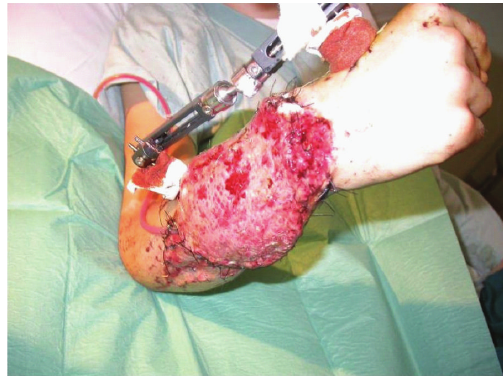
Figure 7: X-ray showing a reduced fracture with plates and screws.